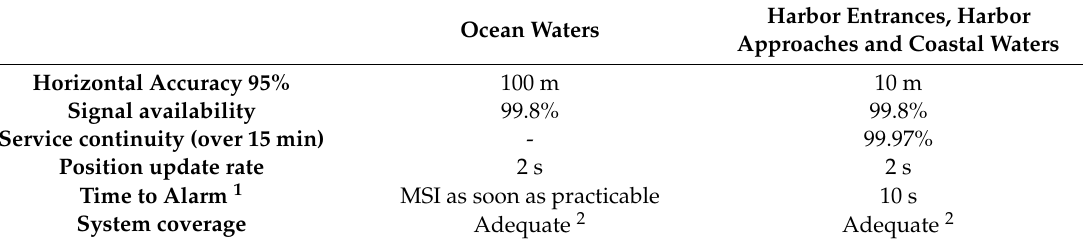
Table 1. Requirements based on IMO A.1046 (27)